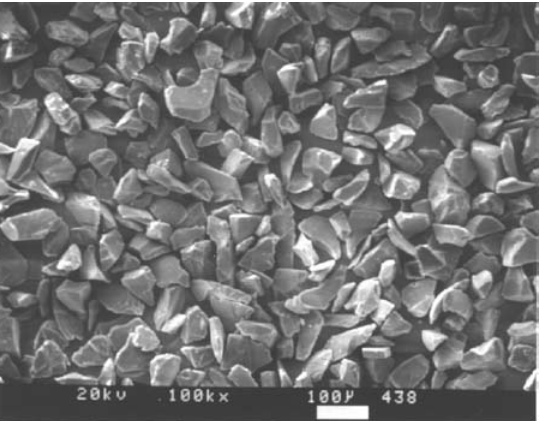
Fig. 2 . SEM Micrograph of the UF 200 × 400 Cut.